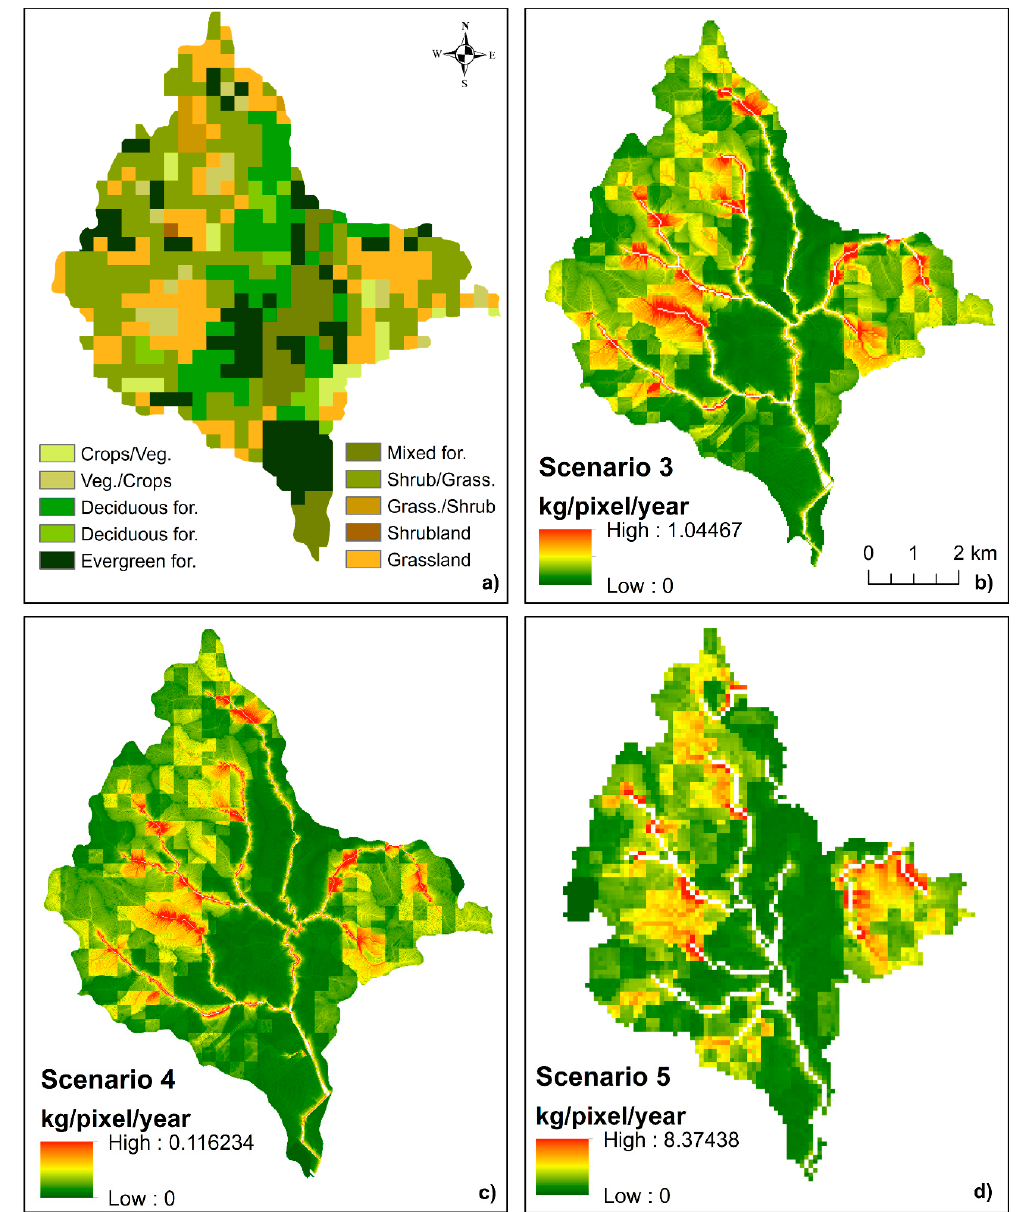
Figure 7. Land cover of the Griffin Lake–Ochlockonee River watershed according to the GlobCover ( a ), and the outputs of the NDR models for the Scenarios 3 ( b ), 4 ( c ), and 5 ( d ) showing the